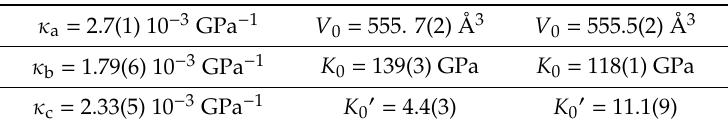
Table 2. Linear compressibilities at zero pressure (left) and room-temperature equation of state (EOS) parameters of Ni 3 V 2 O 8 . The center (right) column shows the converged fitting parameters for the third-order Birch–Murnaghan EOS for P ≤ 7.6 (15.1) GPa. V 0 is the ambient-pressure volume. K 0 is the bulk modulus. K 0 ′ is the pressure derivative of the bulk modulus.